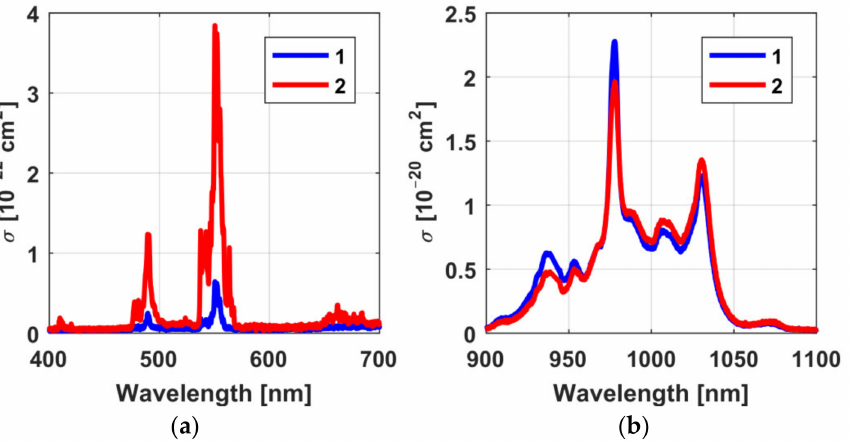
Figure 12. Luminescence spectra in ( a ) visible and ( b ) near-IR range of Yb:Y 2 O 3 ceramics samples. The Sc 2 O 3 material has high thermal conductivity (18 W/m/K for an undoped ma- terial), low phonon energy, and large ground state splitting of doping ytterbium ions, which makes it a potential candidate to be used for AE lasers with high average power.